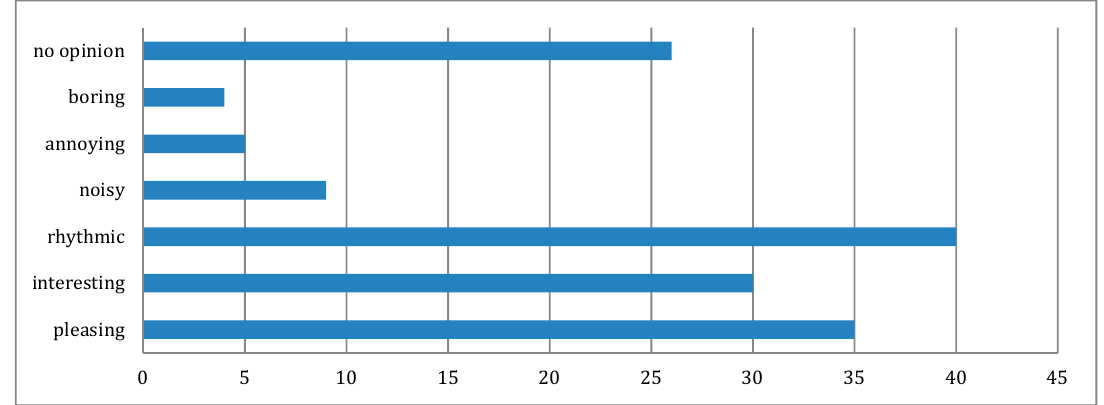
Figure 4. Frequencies of psycho-acoustic descriptors selected by participants in the survey to describe their perceptions of square dancing soundscape.